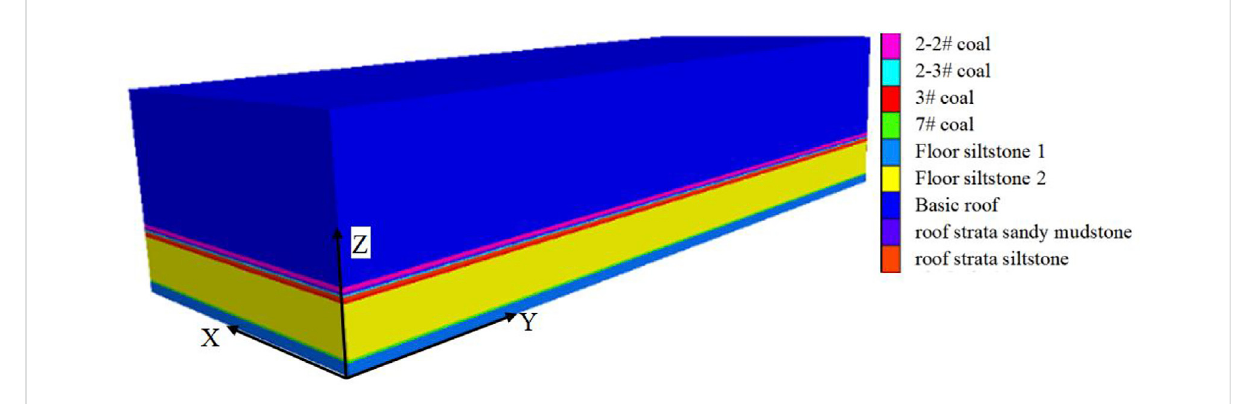
FIGURE 5 Three-dimensional numerical